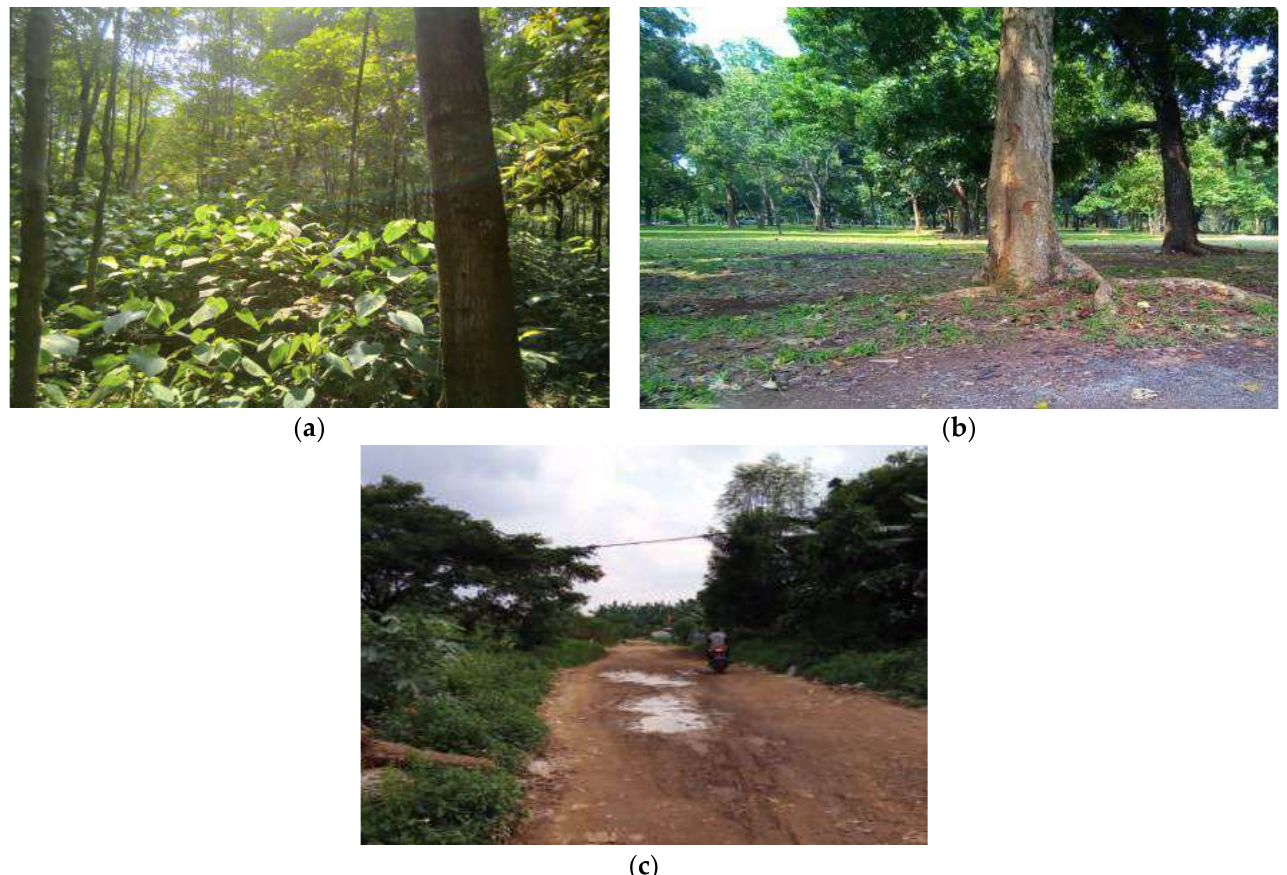
Figure 2. Masurement Environment, ( a ) jungle site, ( b ) forest site, ( c ) open dirt road site.